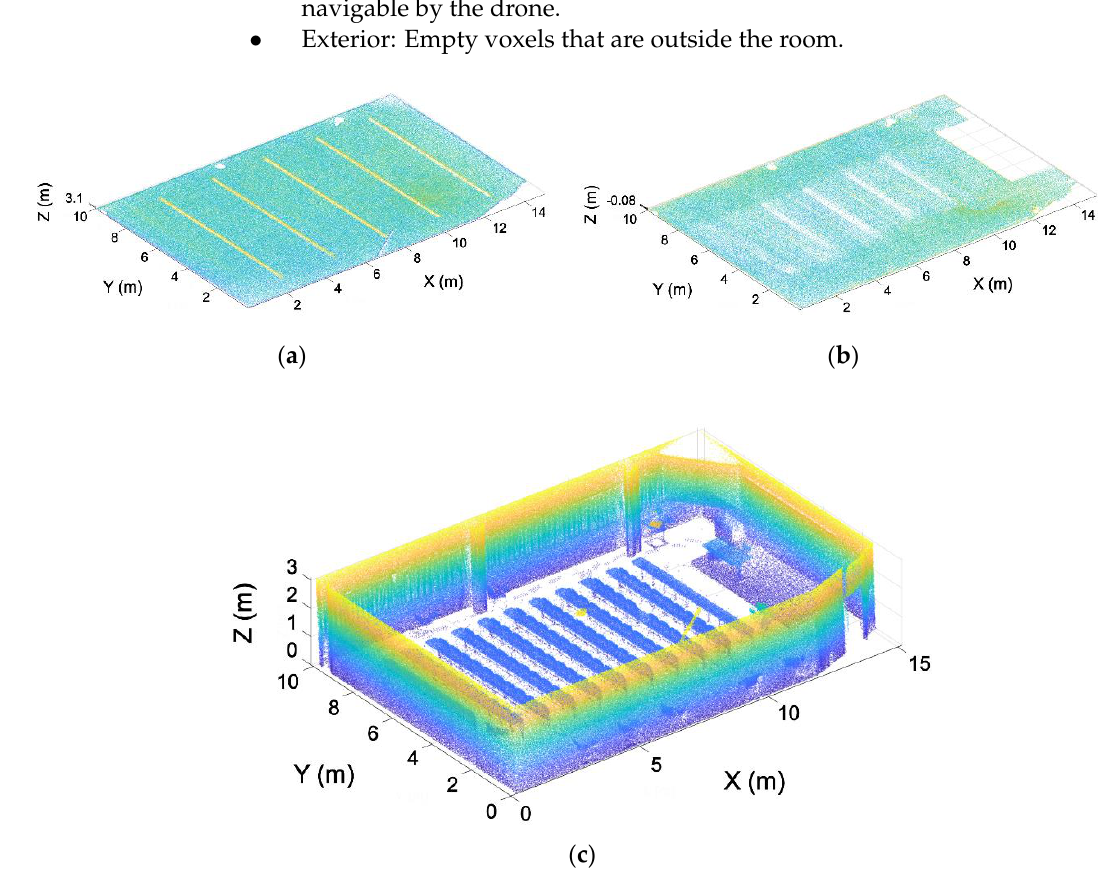
Figure 9. Point cloud segmentation into ceiling, floor, and room. ( a ) Ceiling point cloud. ( b ) Floor point cloud. ( c ) Room point cloud.